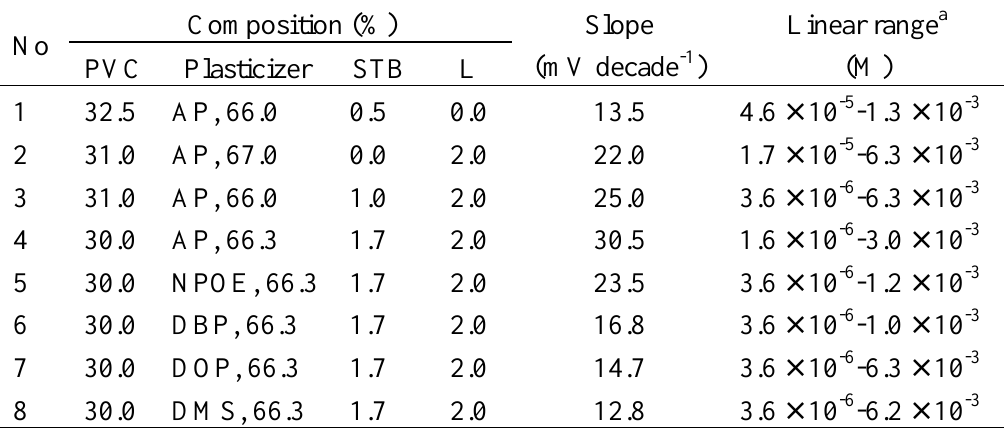
Table 1. Optimization of membrane